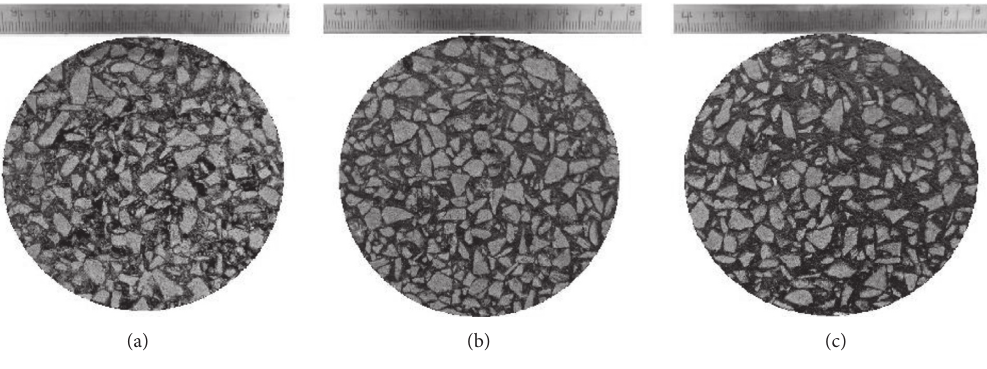
Figure 3: Cross section of the mixes. (a) Mix ref, (b) Mix 1, and (c) Mix